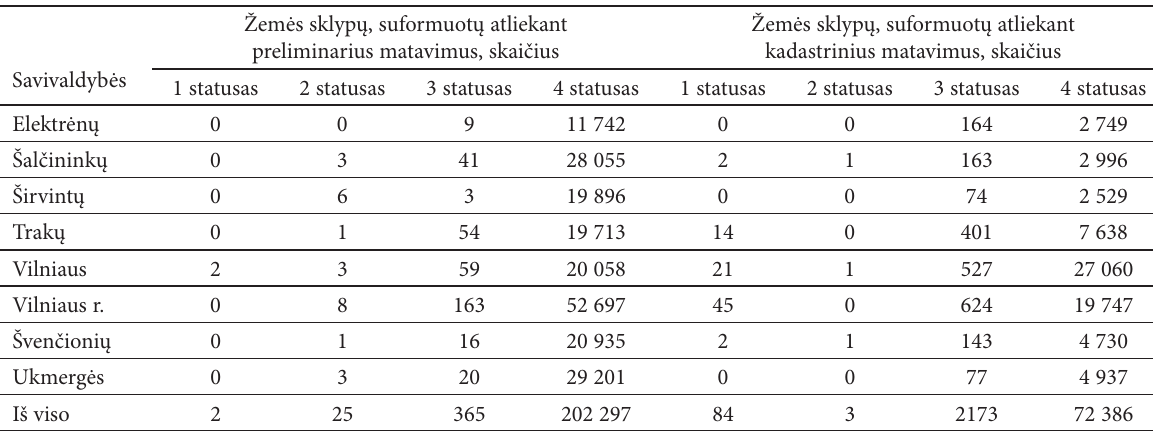
Žemės sklypų, suformuotų atliekant kadastrinius matavimus,